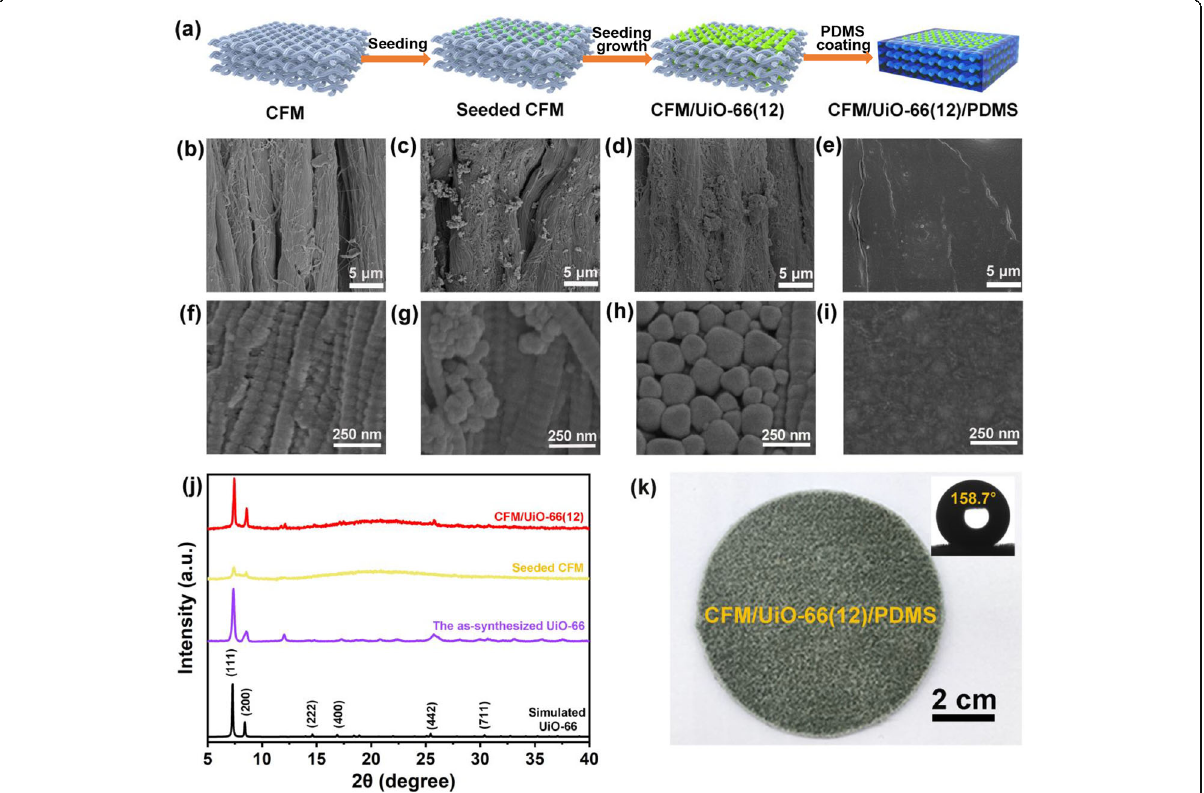
Fig. 1 Schematic illustration showing the fabrication of the CFM/UiO-66(12)/PDMS membrane ( a ), FESEM images of CFM ( b ), the seeded CFM ( c ), the CFM/UiO-66(12) membrane ( d ) and the CFM/UiO-66(12)/PDMS membrane ( e ), the higher magnification images of CFM ( f ), the seeded CFM ( g ), the CFM/UiO-66(12) membrane ( h ) and the CFM/UiO-66(12)/PDMS membrane ( i ), XRD patterns of simulated UiO-66, the as-synthesized UiO- 66, the seeded CFM and the CFM/UiO-66(12) ( j ) and the digital photograph of the CFM/UiO-66(12)/PDMS membrane (inset: the corresponding WCA) ( k